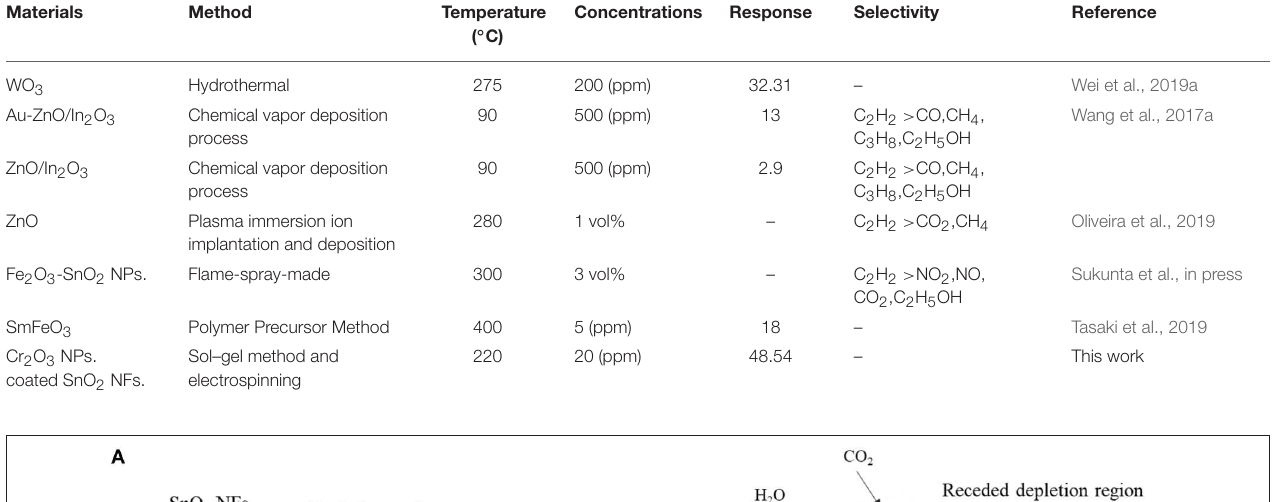
TABLE 1 | The gas-sensing characteristics of C 2 H 2 sensors based on different metal oxides synthesized by various methods.